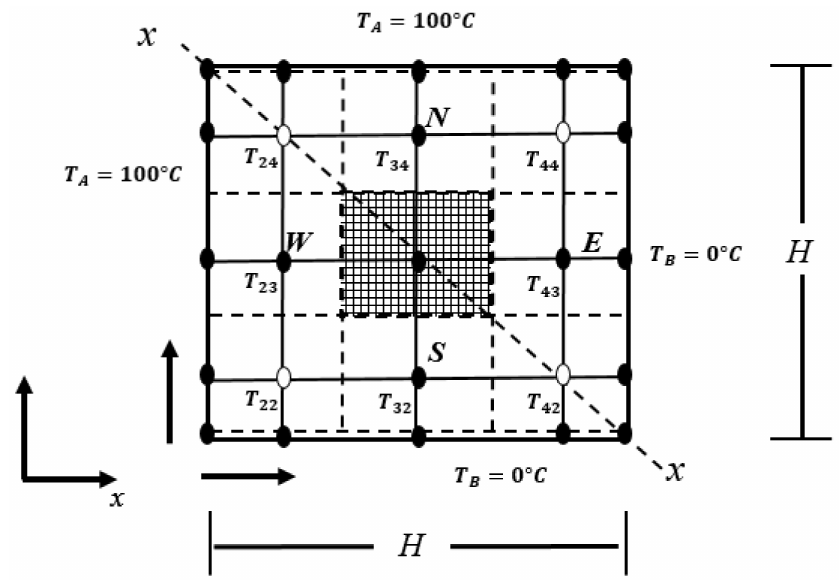
Figure 1. Heat convection-conduction problem (physical model)